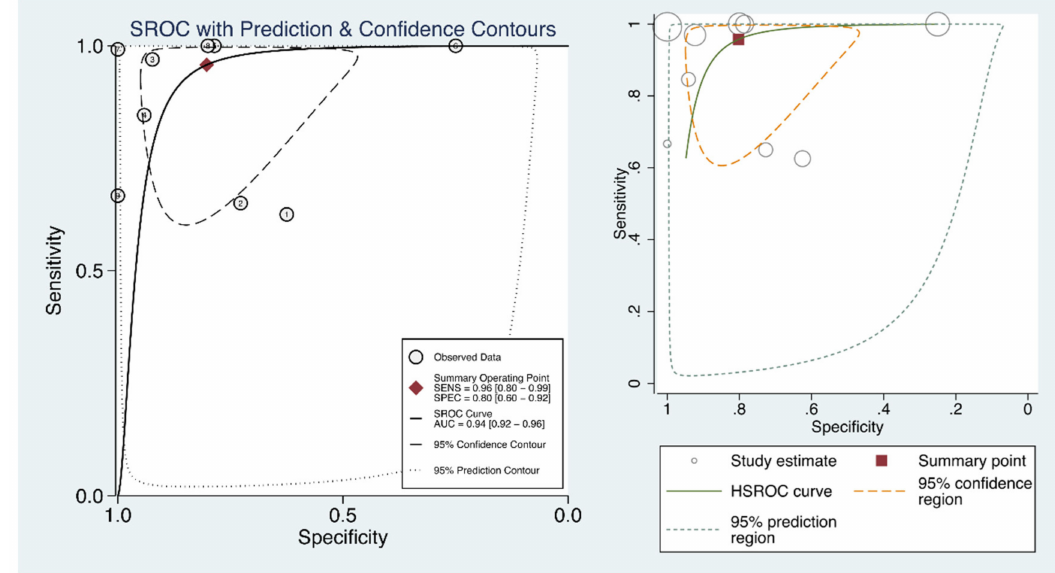
Figure 5. The summary receiver operating characteristic curve of lung ultrasound for the diagnosis of interstitial pneumonia caused by